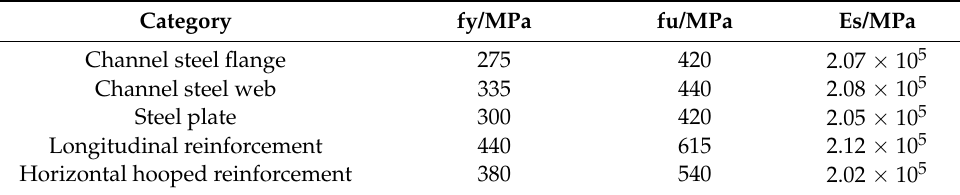
Table 5. Detailed design parameters of the